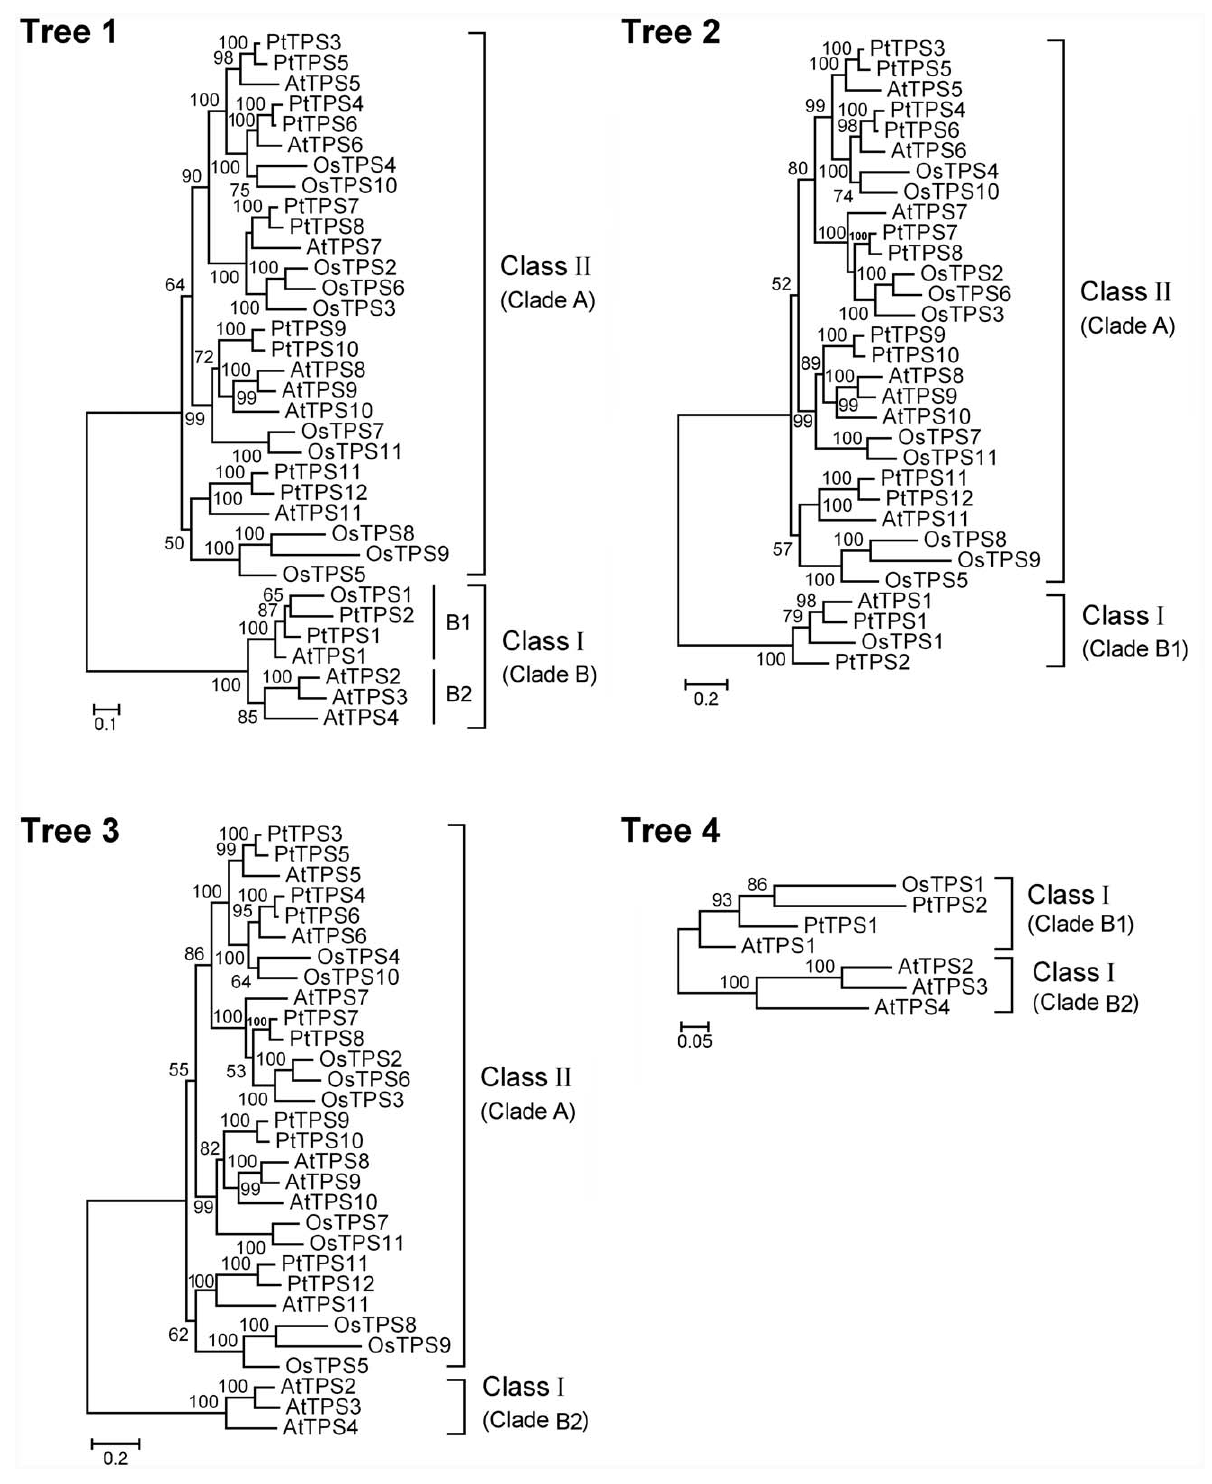
Figure 6. Phylogenetic trees used for molecular evolution analyses. The trees were reconstructed using a maximum-likelihood (ML) procedure with the JTT model and 100 bootstrap replicates. Only bootstrap values . 50% are shown. doi:10.1371/journal.pone.0042438.g006 functionalisation, in which one duplicate gene accumulates nalisation, in which one duplicate copy accumulates beneficial deleterious mutations as a pseudogene, whereas another mutations and acquires a new function, whereas another duplicate gene maintains its original function; (2) neo-functio- duplicate copy retains the original function; (3) sub-functiona-